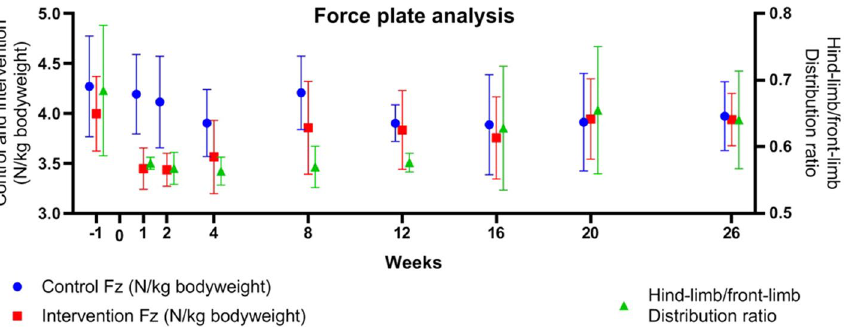
Figure 5. Objective gait analysis by force plate. Mean ± standard deviation force (Fz) (N/kg body weight) on the control (red) and intervention (blue) side, and hind-limb/front-limb distribution ratio (green) before and after acetabular rim extension with a personalized 3D implant that was implanted (week 0) in 3 dogs with hip